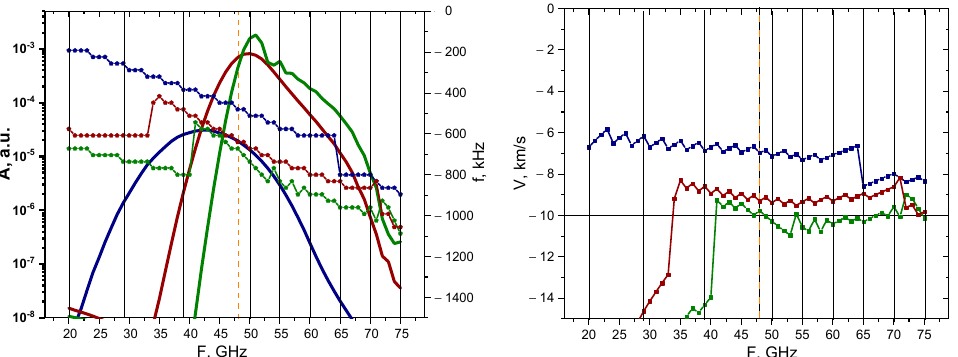
Figure 7. For the circular filament with an amplitude of 0.1%: ( left ) dependency of the DBS signal amplitude (bold lines with scale on the left) and frequency (lines with pentagon shapes with scale on the right) on the probing frequency; ( right ) dependency of the calculated velocity on the probing frequency. The navy-blue lines are the circular filament with a 3 cm diameter, the wine-red are that of 1.5 cm, and the olive-green are that of 0.5 cm. The black vertical lines indicate the probing frequencies available in Globus-M2, and the vertical orange dashed line indicates the position of the filament at cutoff of the 48 GHz probing wave. The horizontal line marks the set 10 km/s filament velocity. The Doppler frequency shift (signal frequency) was then used to calculate the filament velocity by the formula V = ∆ ω / k , where k = 2 k 0 sin α is the wave vector detected 10 km/s (horizontal line on the right), which allowed us to meaningfully analyze the estimated velocities. In the case of the 0.5 cm diameter filament, the results were accurate for the 35–75 GHz probing frequencies, while the other two cases (blue line—3 cm and red line—1.5 cm) provided velocity measurements of higher